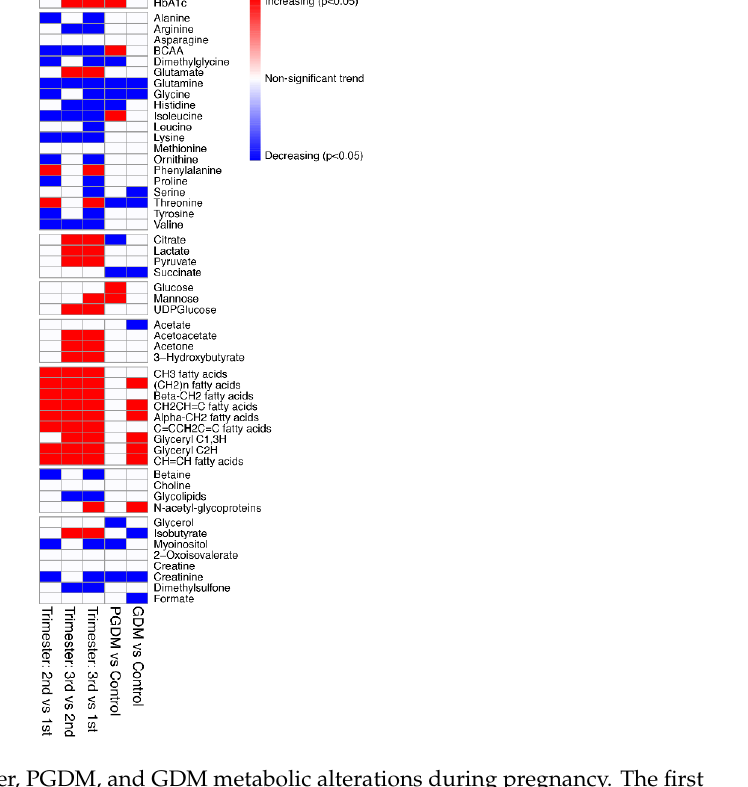
Figure 2. Heatmap of trimester, PGDM, and GDM metabolic alterations during pregnancy. The first three columns represent results of a post-hoc analysis of metabolites that differed between first, second, and third trimesters in all women during gestation, regardless of diabetes diagnosis. The last two columns represent metabolites altered between women with PGDM compared to controls or GDM compared to controls across all trimesters. Metabolites with a significant p -value ( p < 0.05) are represented by red if they are increased and blue if they are decreased. If no significant change exists,